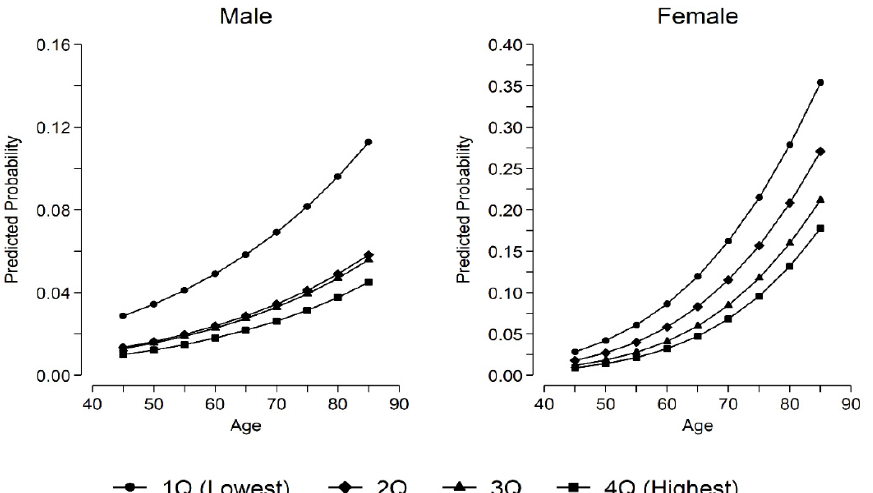
Figure 2. Predicted Probability of Being Close to Alzheimer’s by Gender and Handgrip Strength Quartiles: Korean Longitudinal Study of Aging (KLoSA).